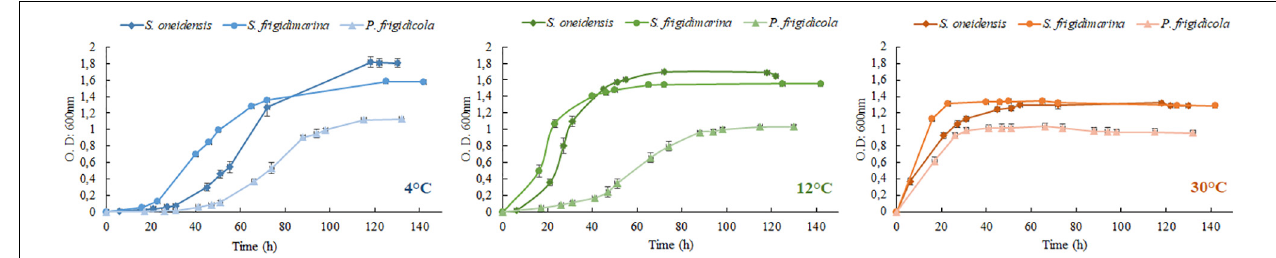
FIGURE 1 | Growth curves of S. oneidensis , S. frigidimarina , and P. frigidicola at 4 (blue), 12 (green), and 30 ◦ C (red/orange).